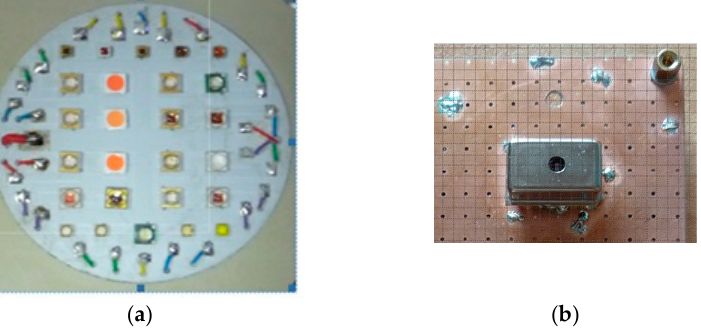
Figure 4. The view selected components of the hardware simulator: ( a ) the LED matrix on an alu- minum substrate; ( b ) the MEMS sensor on the bottom side of the board MEMS spectrometer module.